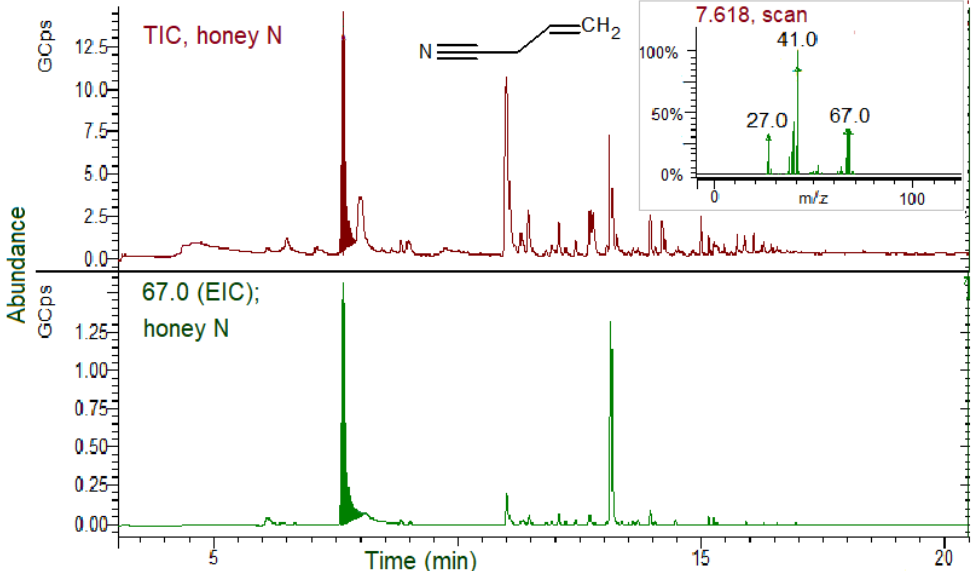
Figure 6. SPME GC–MS analysis of honey produced by bees fed on B. nigra patties (N group) for 28 days. TIC, total ion chromatogram; EIC; extracted ion chromatogram (67.0 m / z for allyl cyanide, ACN). Inset: ACN MS spectrum.